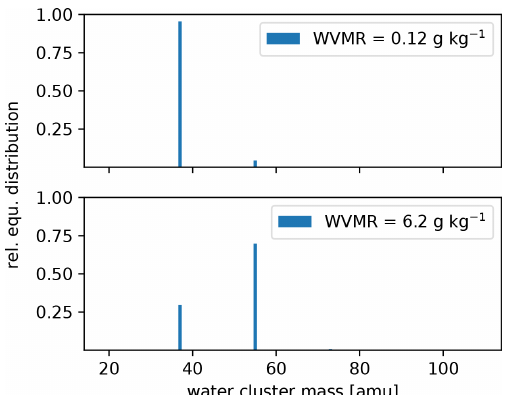
Figure C1. Calculated equilibrium (equ.) primary ion distribution in the PTR3 at the minimum and maximum water vapor mixing ratio (WVMR) inside the PTR3 during the sampling period.